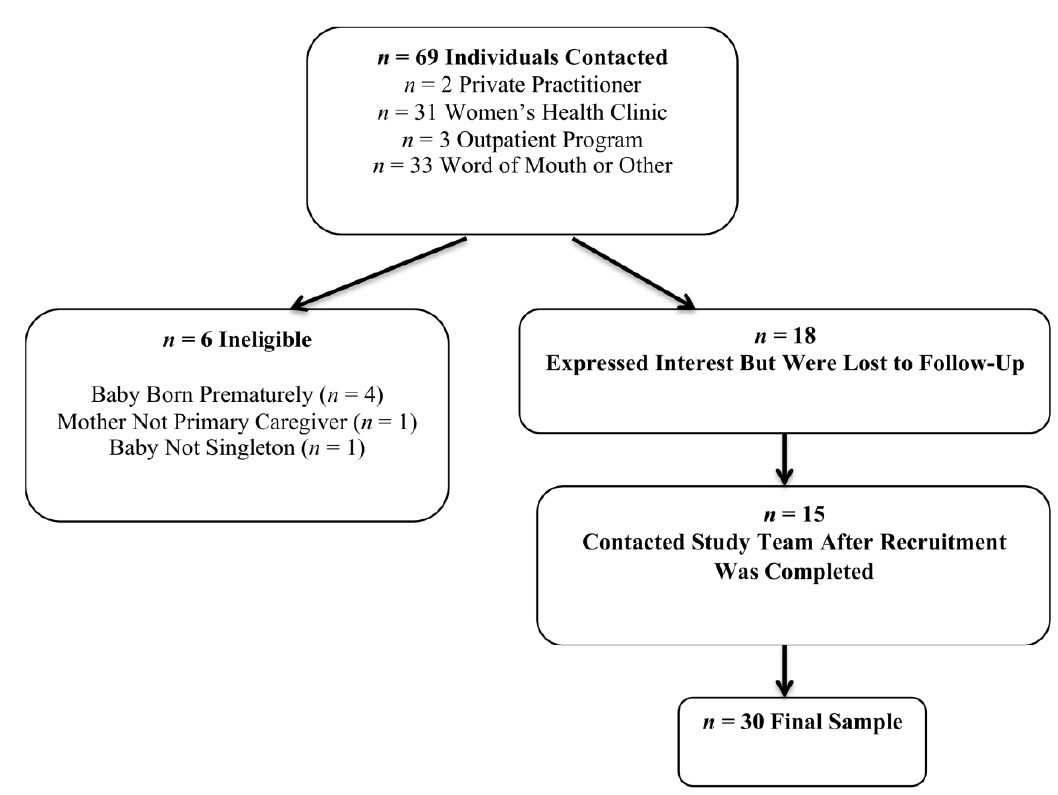
Figure 1. Participant recruitment, enrollment, and flow information.